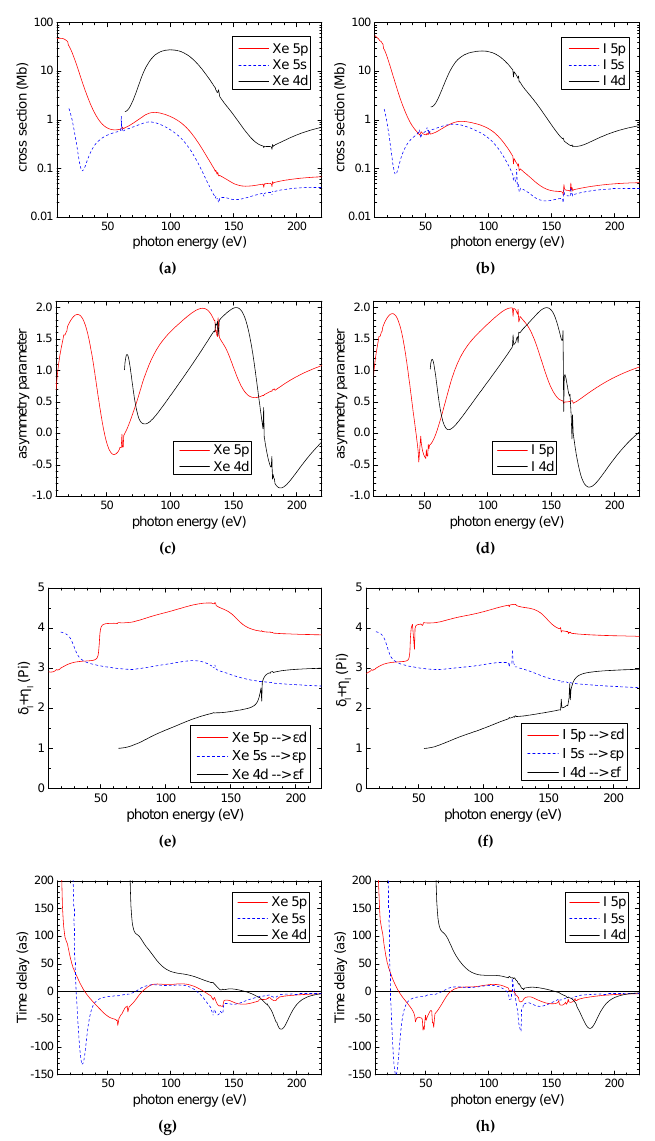
Figure 1. Left to right columns: calculations for xenon ( a , c , e , g ) and iodine ( b , d , f , h ) atoms. Top to bottom rows: partial cross section ( a , b ), asymmetry parameter ( c , d ), short-range plus induced phase shift ( e , f ), and Wigner time delay ( g , h ) for subshells 5 p , 5 s and 4 d